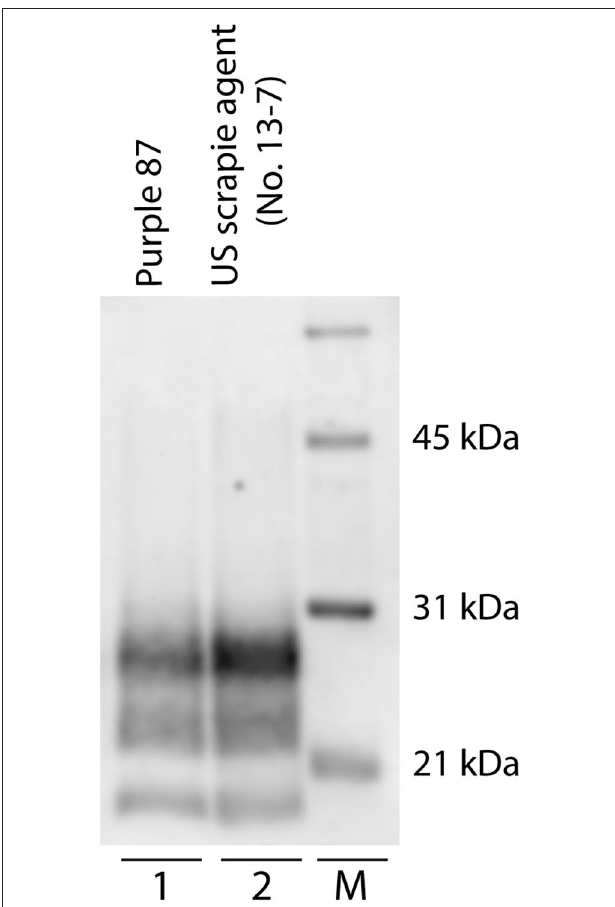
FIGURE 3 | Western blot migration patterns of caprine and ovine scrapie. Proteinase K digestion of brain homogenates from goats and sheep naturally infected with scrapie reveals three immunoreactive bands that represent ratios of three glycoforms. Western blot analysis of PrP Sc reveals similar band patterns of scrapie-positive caprine (lane 1, animal purple 87) and ovine (lane 2). Animal P87 is a representative blot of all scrapie-positive caprine. M: molecular weight